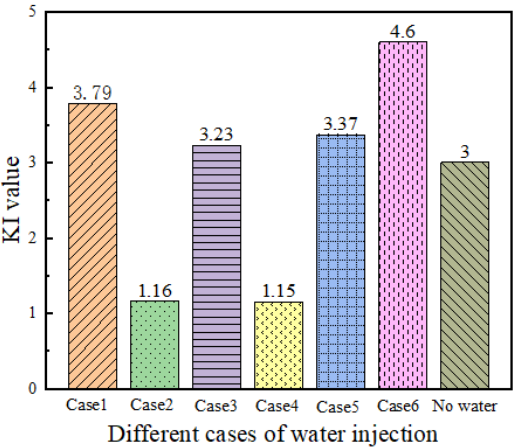
Figure 15. KI values of each case (CR = 10.3, ignition time = − 14 degCA).